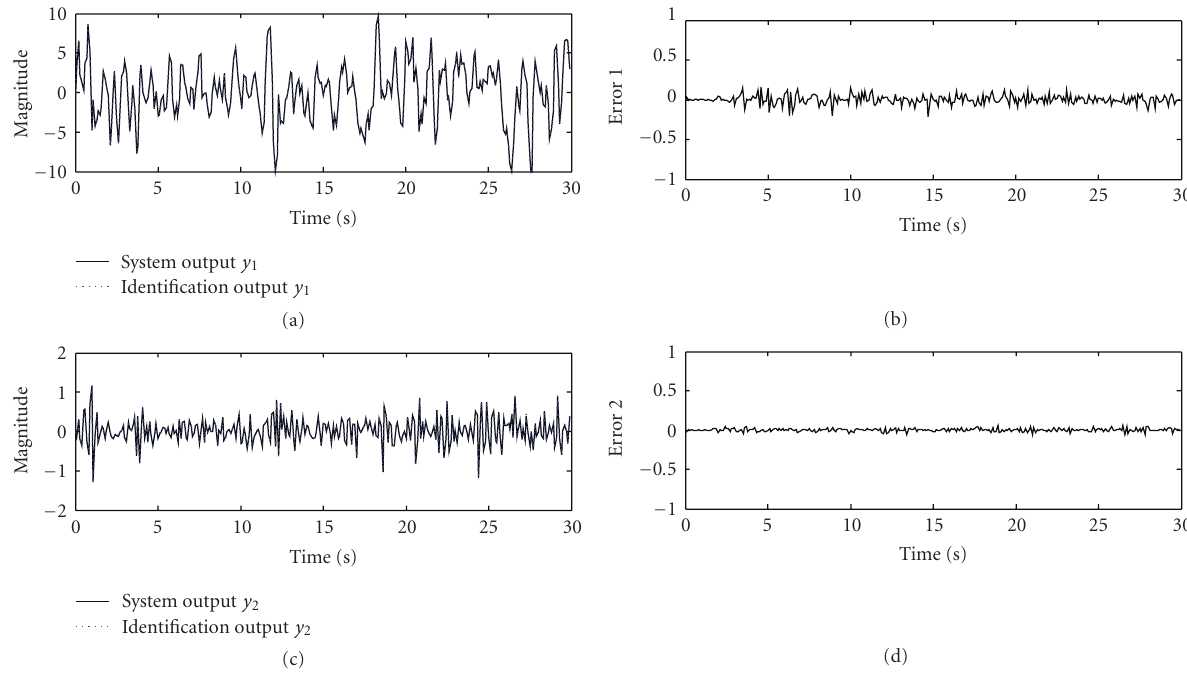
Figure 9: The trajectories of outputs using RELS method with